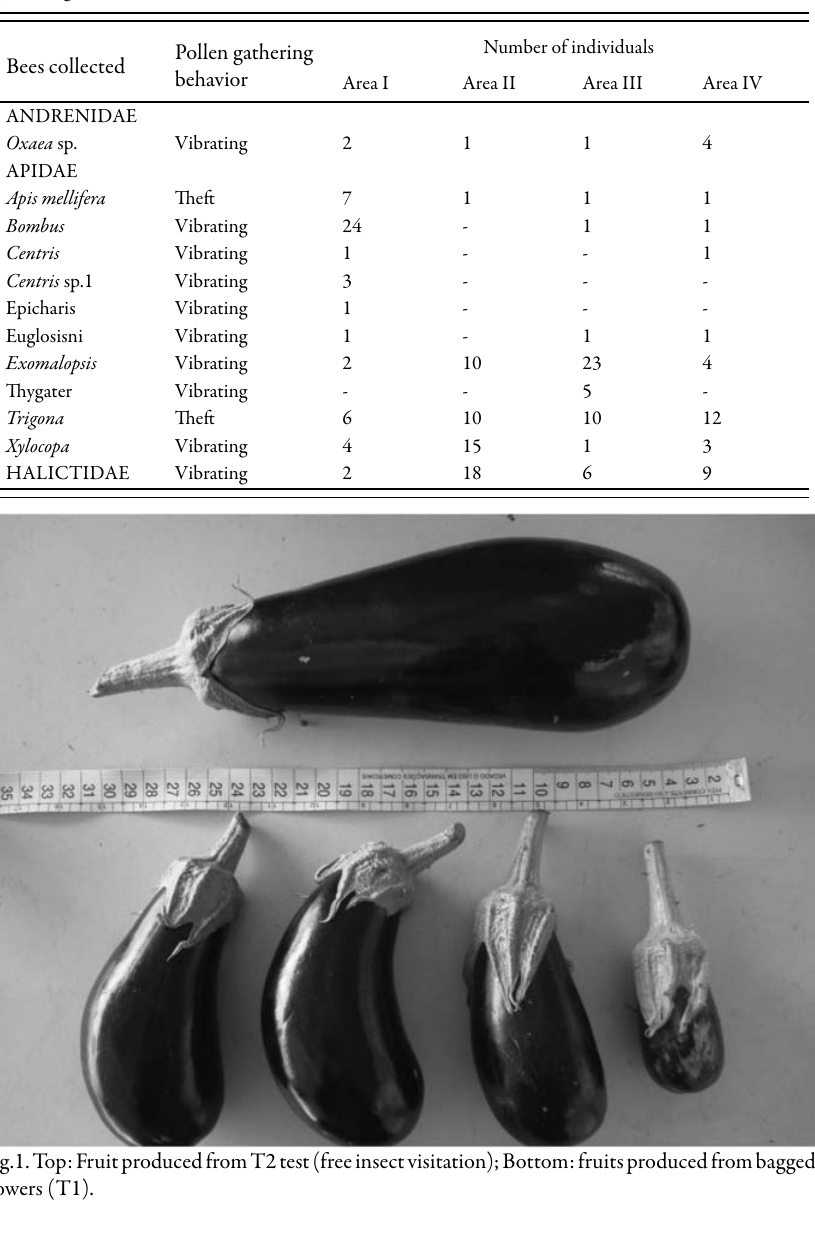
Table 2. Number of bee specimens collected on eggplants ( S. melongena L.) flowers and their pollen gathering behavior. - Absence of bees.